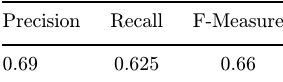
Table 3. Performance scores.